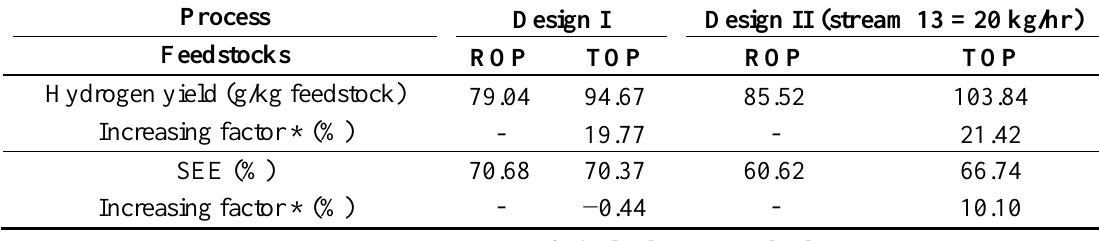
Table 5. Hydrogen yield and SEE at the S/C ratio of 1.2.